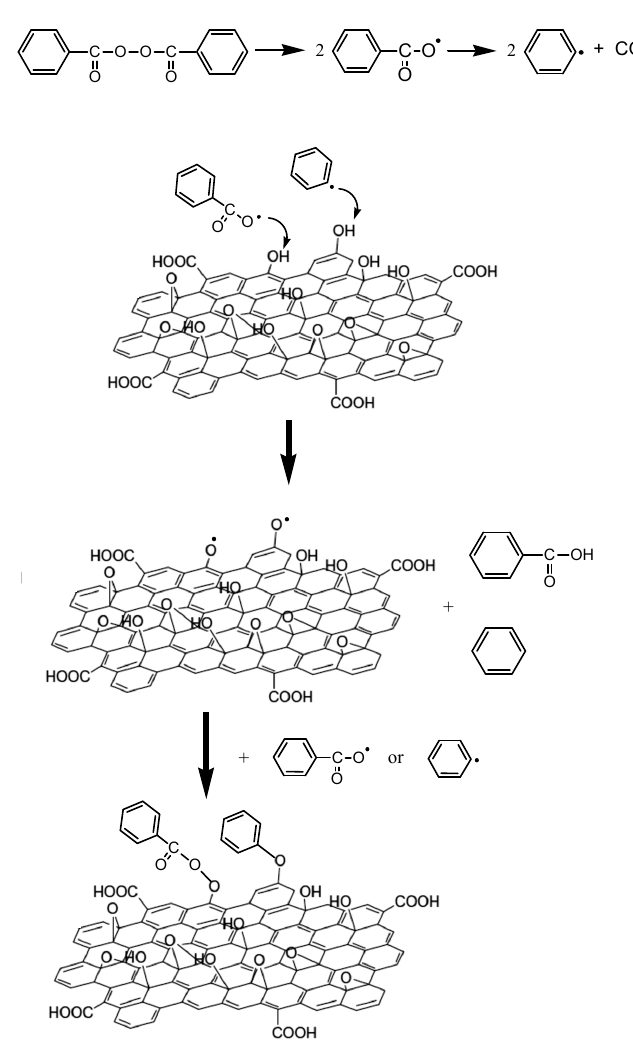
Scheme 1. Schematic illustration of the reaction of primary initiator radicals with GO resulting in their deactivation and reduction of the initiator efficiency.